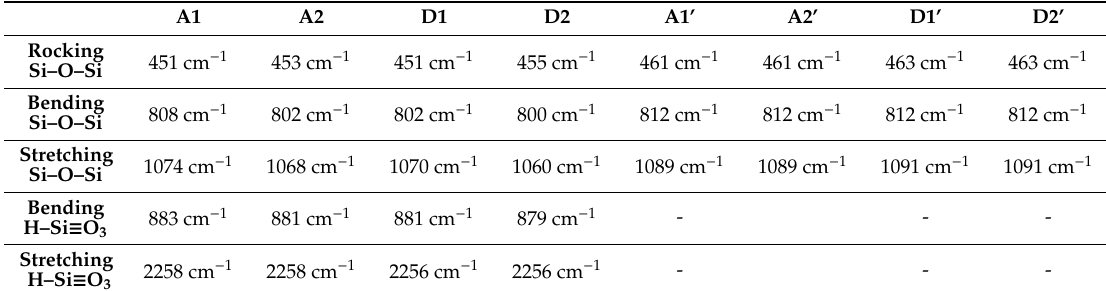
Table 3. Peak positions present in the spectra of Figure 5, as well as the vibrational modes and the type of molecule to which they are attributed.